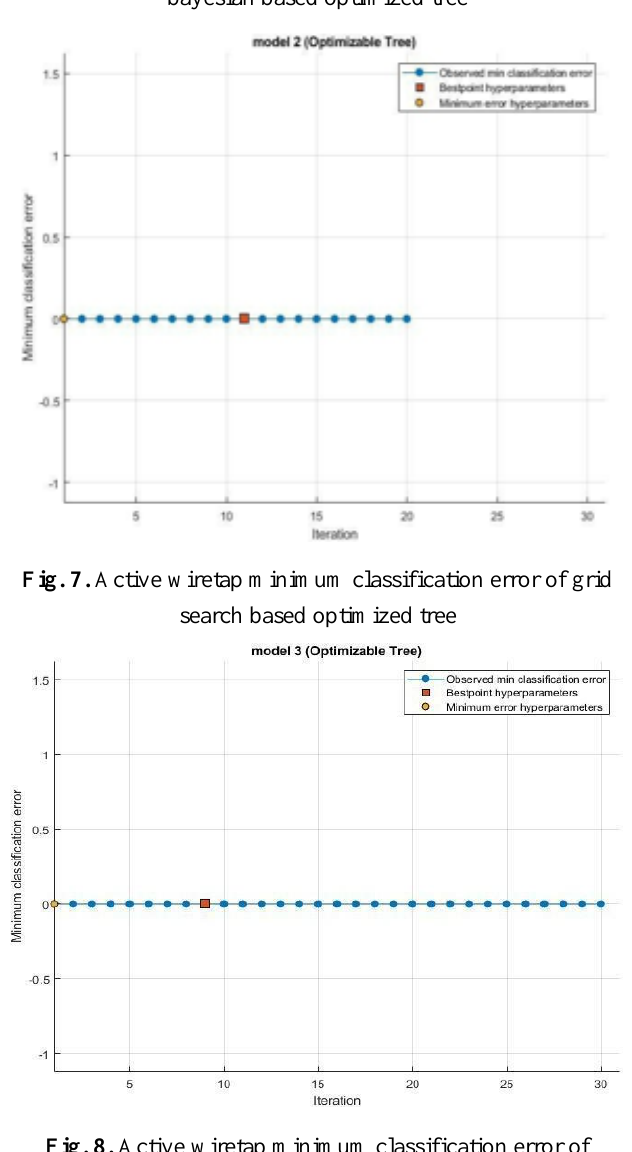
Fig. 8. Active wiretap minimum classification error of random search based optimized tree